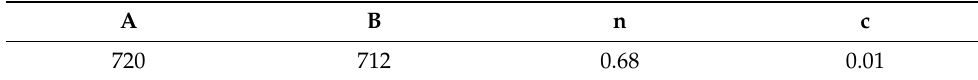
Table 1. Johnson–Cook parameters of 20CrMnTi.